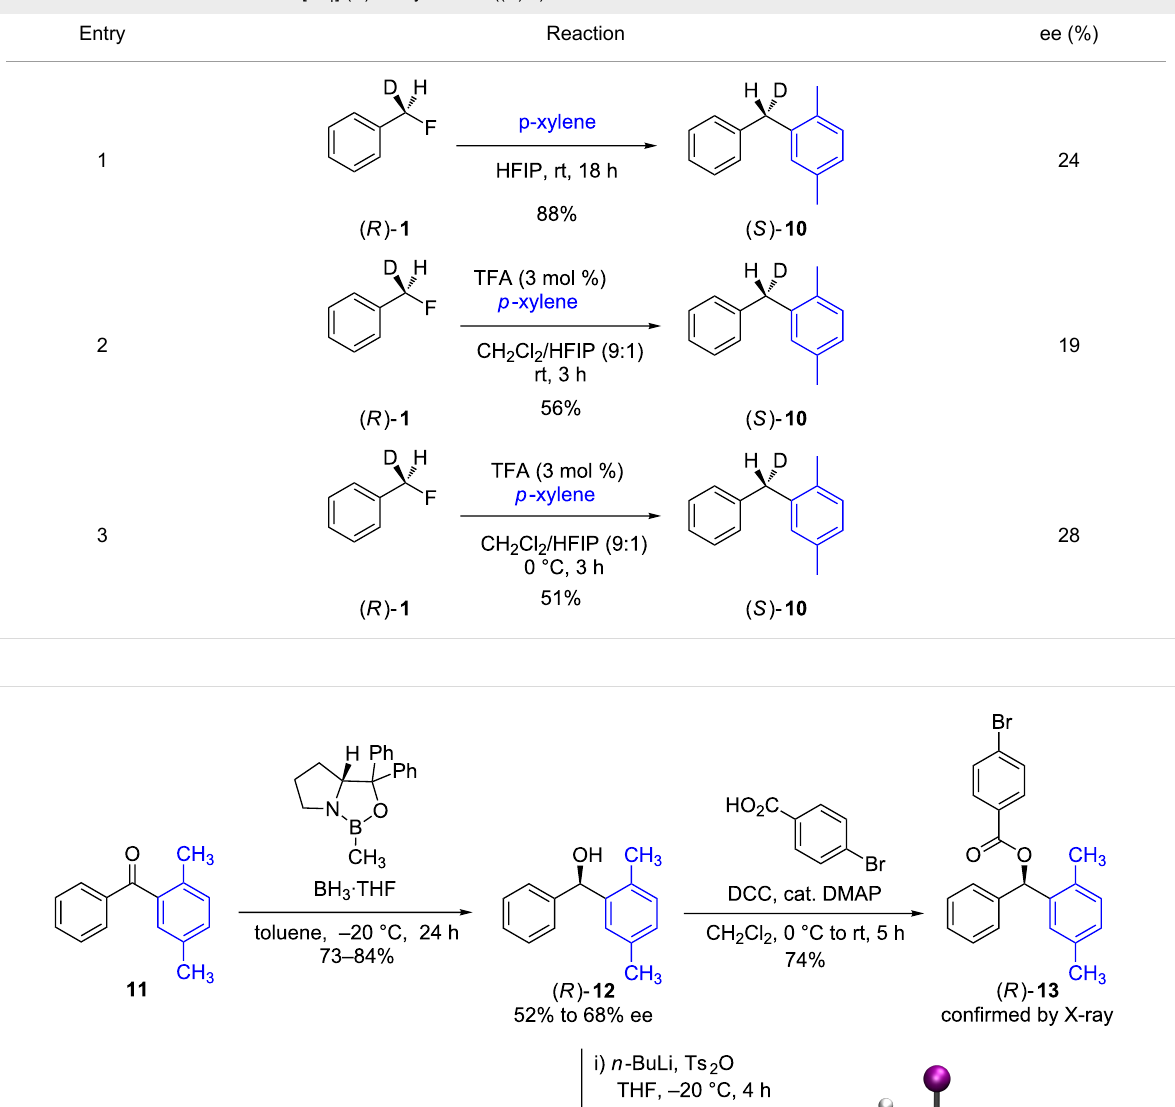
Table 3: Friedel–Crafts reactions of 7-[ 2 H 1 ]-( R )-benzyl fluoride (( R )- 1